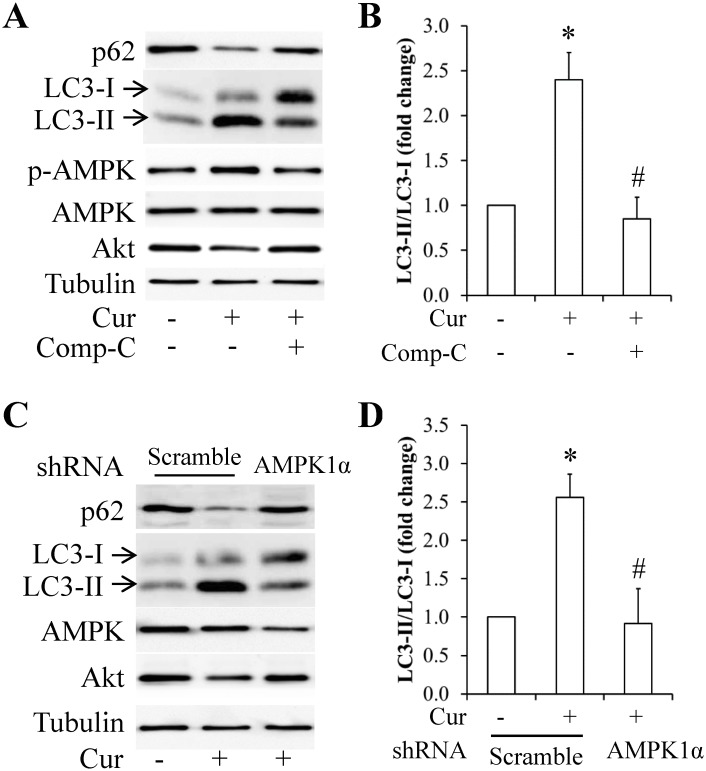
AMPK mediated curcumin action on autophagy in MDA-MB-231 cells.(A) A representative western blot band of autophagosome markers in cells treated with AMPK specific inhibitor compound C (Comp-C). (B) Quantitative analysis of LC3-II/LC3-I ratio in (A). (C) A representative western blot band of autophagosome markers in AMPK1α knockdown cells. (D) Quantitative analysis of LC3-II/LC3-I ratio in (C). Data are means ± SEM. (n = 4). * p<0.05 vs DMSO control; # p<0.05 vs curcumin-treated group.